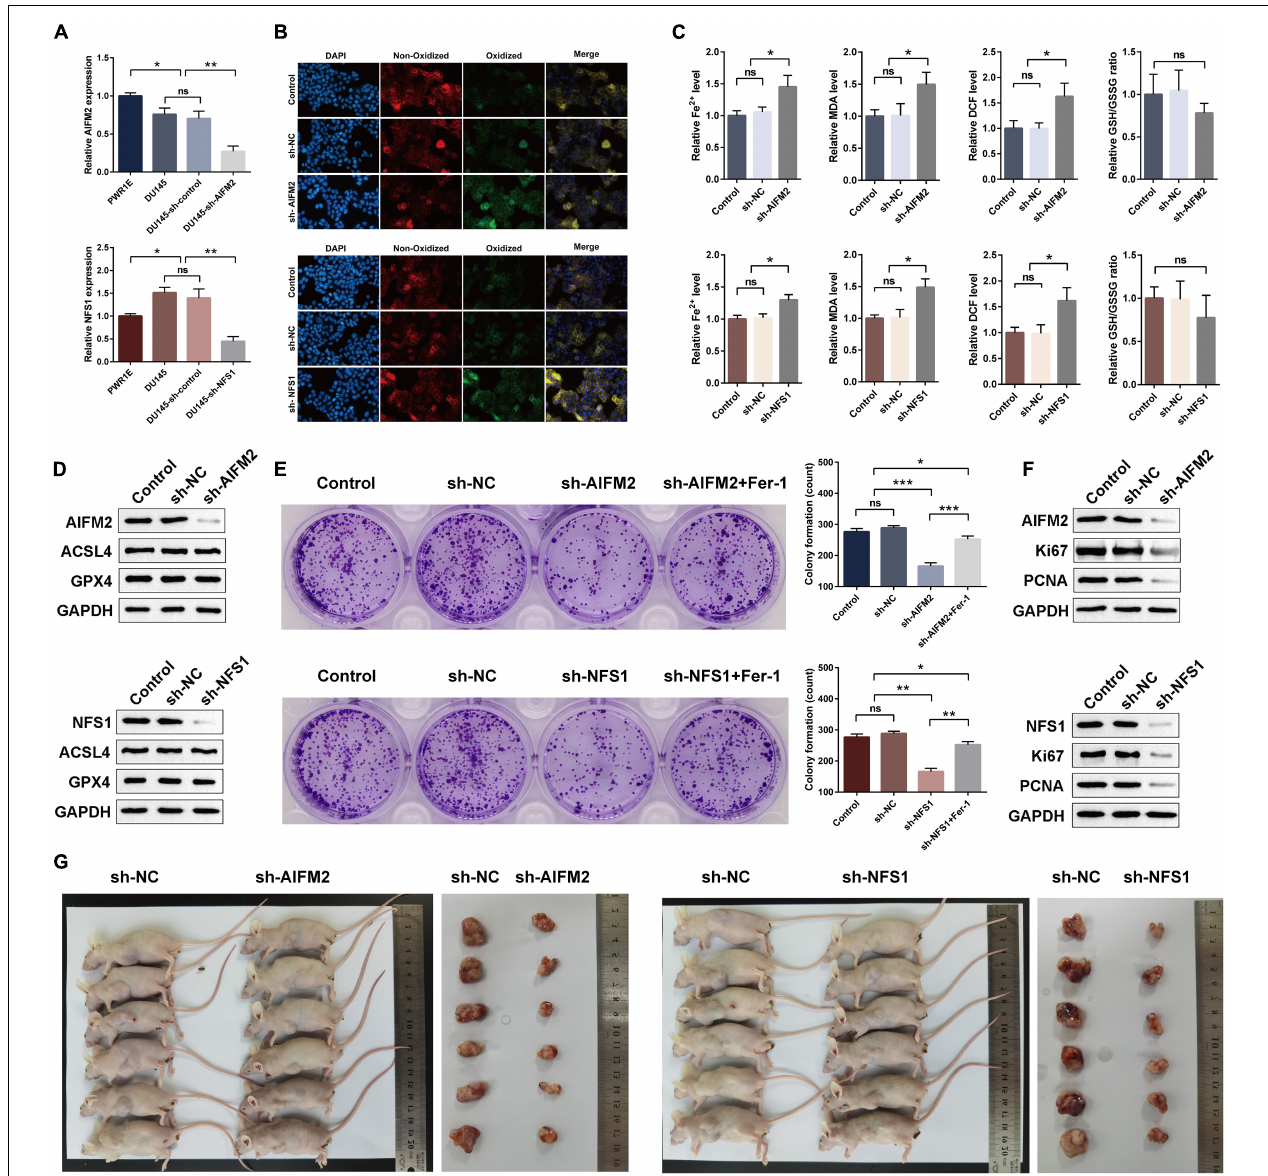
FIGURE 13 | AIFM2 and NFS1 knockdowns promote ferroptosis and suppress proliferation in vitro and in vivo . (A) The real-time quantitative polymerase chain reaction (RT-qPCR) analysis of AIFM2 and NFS1 expression levels in PWR1E, DU145, DU145 sh-control, and DU145 sh- AIFM2/NFS1 . (B) Immunofluorescence staining of oxidized lipid ROS (green color) and reduced lipid ROS (red color) formation in DU145 after AIFM2/NFS1 knockdown. (C) Fe 2 + release, MDA, DCF, and GSH levels detected by Assay Kit in DU145 cells after AIFM2/NFS1 knockdown. (D) The Western blot analysis of ACSL4 and GPX4 expression levels after AIFM2/NFS1 knockdown. (E) Colony formation assays were constructed in AIFM2/NFS1 knockdown DU145 cells. (F) The Western blot analysis of Ki67 and PCNA expression levels after AIFM2/NFS1 knockdown. (G) Xenograft tumors in nude mouse models (* p < 0.05; ** p < 0.01; *** p <